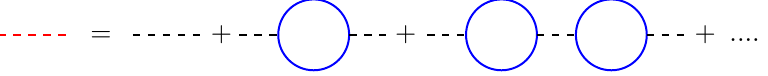
Figure 2 . (bQED + ) HS (cid:12)eld (cid:27) + e(cid:11)ective propagator (red dashed line). The black dashed line stands for tree level HS (cid:12)eld